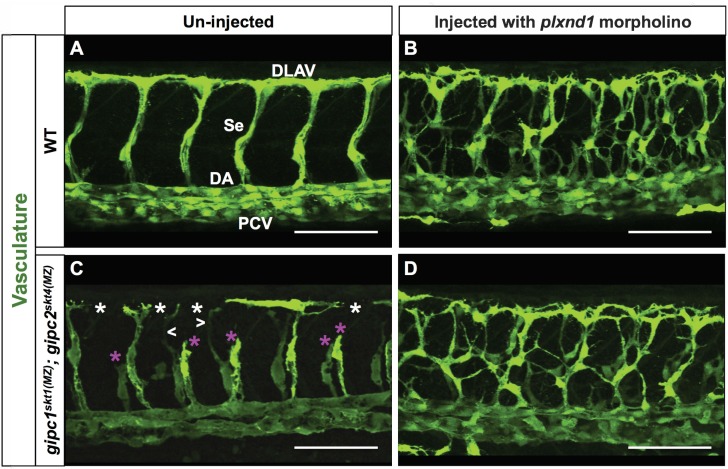
Removal of plxnd1 activity from gipc1skt1(MZ); gipc2skt4(MZ) maternal-zygotic (MZ) double mutants yields a phenotype similar to that of plxnd1 nulls.(A–D) Confocal lateral images of the trunk vasculature (green) of 32 hpf embryos (region dorsal to the yolk extension). Anterior, left; dorsal, up. Scale bars (white horizontal lines), 100 μm. Morpholino injection (un-injected or injected with plxnd1 morpholino) indicated on top, genotypes (WT or gipc1skt1(MZ); gipc2skt4(MZ)) indicated on the left. The un-injected WT picture (A) shows the names of the major vessels in white font: DLAV (Dorsal Longitudinal Anastomotic Vessel), Se (Segmental Vessel), DA (Dorsal Aorta), and PCV (Posterior Cardinal Vein). Vascular defects highlighted as follows: truncated or missing Se (magenta asterisk), thin Se (white greater/less-than signs), DLAV gaps (white asterisk). Quantifications. The following number of embryos were analyzed: WT (four embryos), WT injected with plxnd1 morpholino (four embryos; 4/4 showed a vascular phenotype similar to that of plxnd1fov01b nulls), gipc1skt1(MZ); gipc2skt4(MZ) (12 embryos; 7/12 showed angiogenesis deficits), and gipc1skt1(MZ); gipc2skt4(MZ) injected with plxnd1 morpholino (11 embryos; 11/11 showed a vascular phenotype similar to that of plxnd1fov01b nulls).